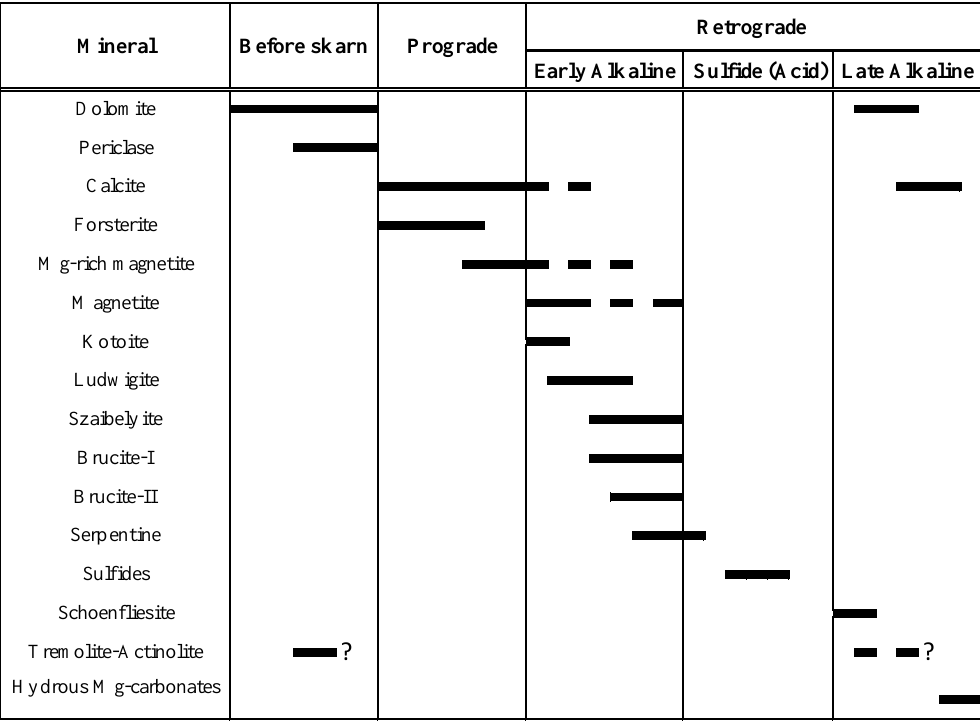
Figure 13. Proposed paragenetic sequence for the El Robledal deposit.